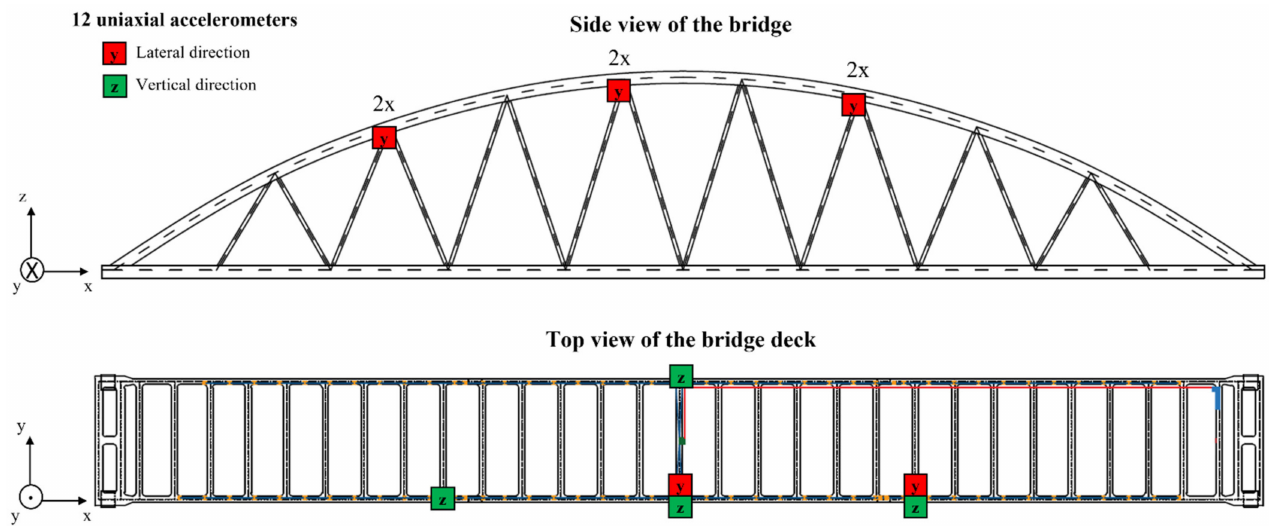
Figure 4. Layout of the acceleration measurement setup of the KW51 bridge. The side view shows the sensors installed on the connections between the diagonals and the arches, while the top view illustrates the sensors installed on the bridge deck. (Adapted from ref.